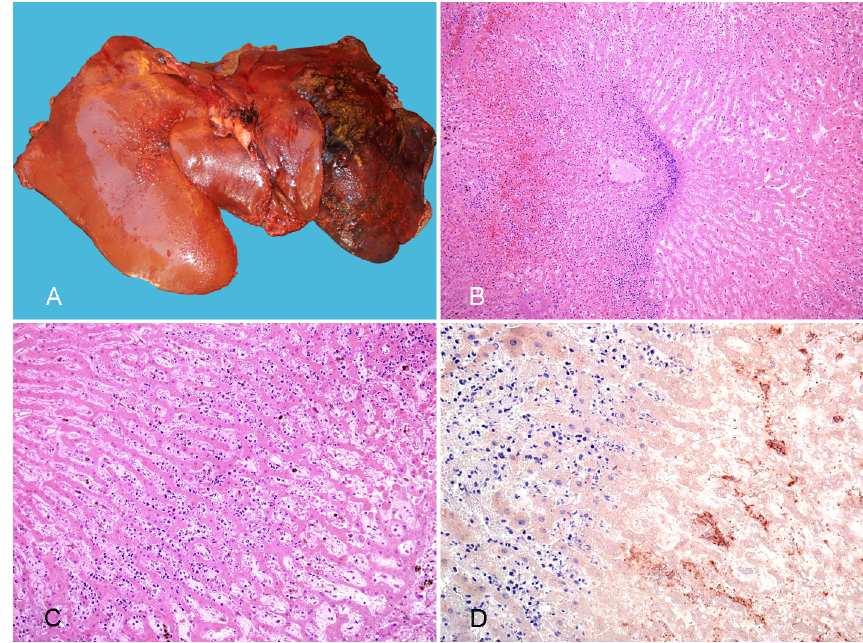
Figure 5. Liver from a horse with infectious necrotic hepatitis produced by Clostridium novyi type B. ( A ) A large focus of necrosis involves most of the left hepatic lobe. Photo reproduced from [79]. ( B ) The area of coagulative necrosis (right) is separated from an area of more viable-looking hepatic parenchyma (left) by a band of inflammatory cells; HE. Reprinted with permission from ref. [79]. Copyright 2018 J Vet Diag Invest. ( C ) Higher magnification of the band of inflammatory cells, composed mostly of neutrophils, surrounding the focus of necrosis; HE. ( D ) Strongly positive rods in the periphery of the focus of necrosis; C. novyi IHC.